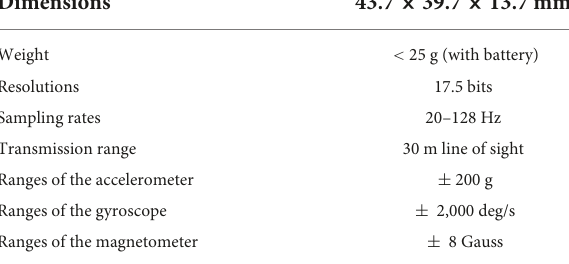
TABLE 2 Specifications of the OPAL IMU system (27).